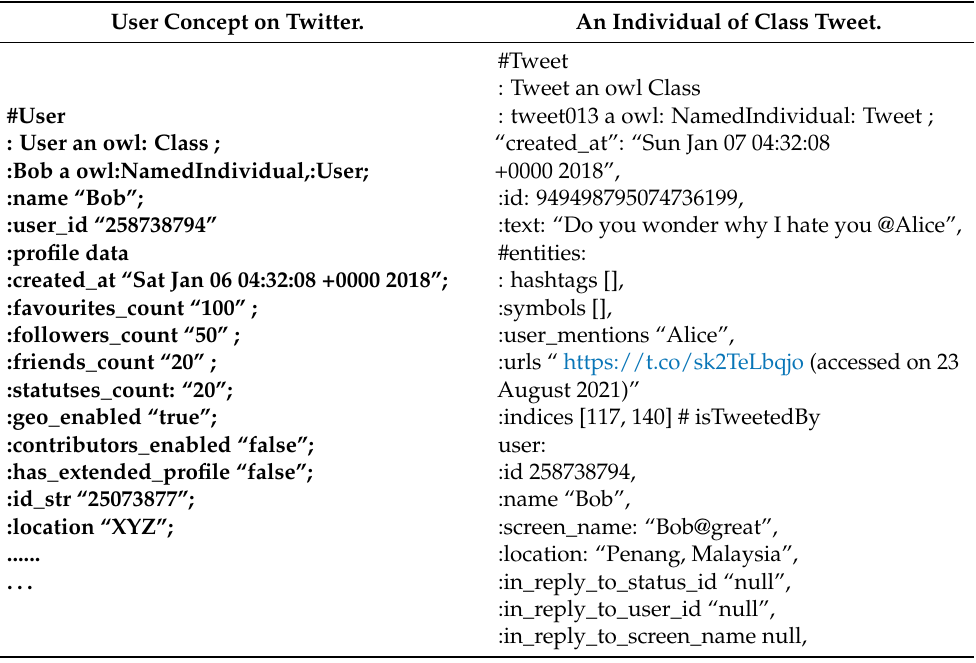
Table 2. Turtle serialized data representation of USER and TWEET construct in the data model and RDF stores. User Concept on Twitter. An Individual of Class